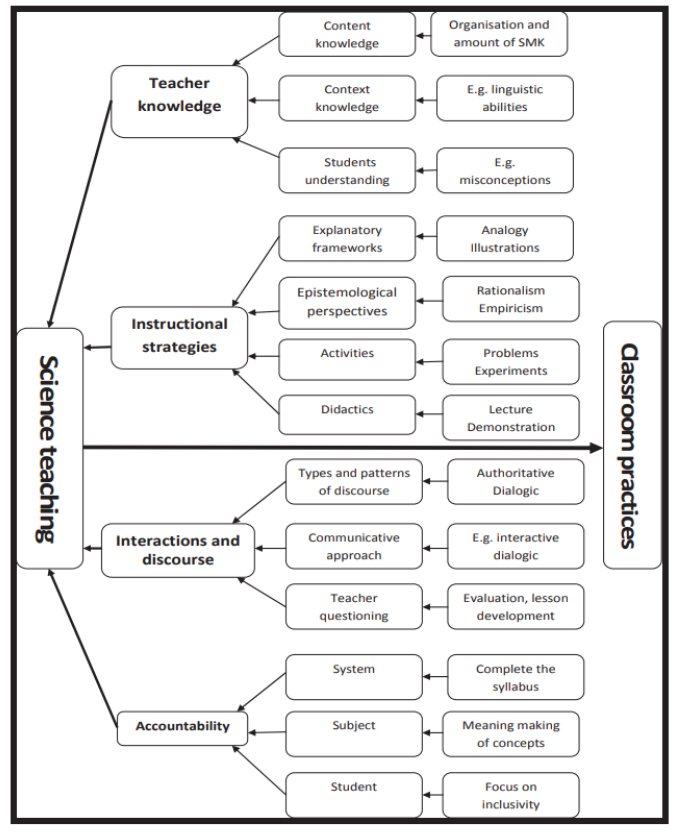
Figure 1: The Classroom Practice Diagnostic Framework (Mudau,